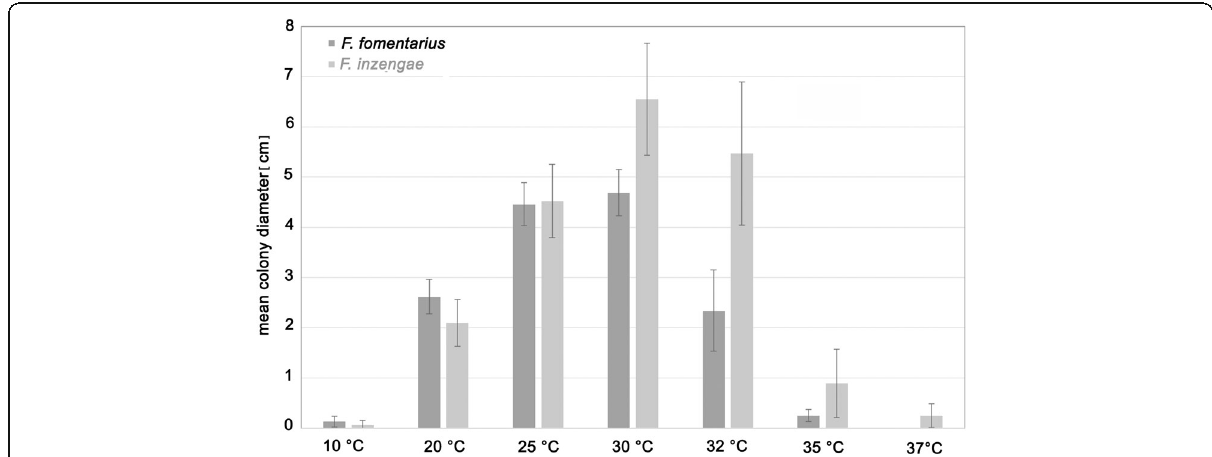
Fig. 6 Mean colony diameter after 5 d on 3% MEA at different temperatures. F. inzengae grows significantly faster at temperatures of 30 °C and higher, but slower at 20 °C and below. With the exception of 25 °C, differences in growth rates between F. fomentarius and F. inzengae are always highly significant ( p < 0.0001) ( n =